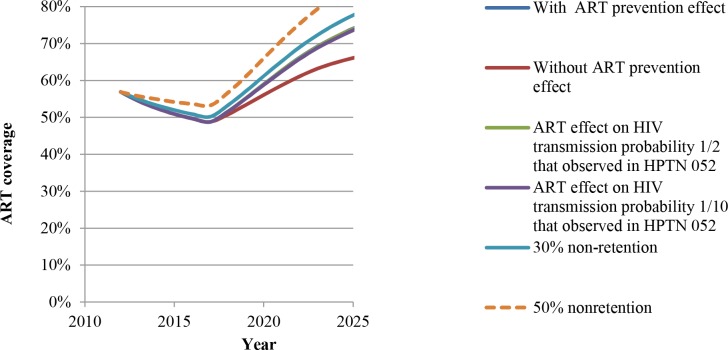
Trajectory of ART coverage in South Africa if human resources for treating HIV/AIDS (HRHA) were to stay constant at the initial level.Coverage shown for the following cases: assuming ART does not have prevention effects; assuming ART prevention effects are as observed in the HPTN 052 trial; ART prevention effects that are 1/2 or 1/10th of that observed in the HPTN 052 trial; and assuming ART non-retention rate is 30% or 50%. The lines for the following three cases are very close and hence all lines are not visible: with ART prevention effect, ART effect on HIV transmission probability 1/2 of that observed in HPTN 052, and ART effect on HIV transmission probability 1/2 of that observed in HPTN 052.